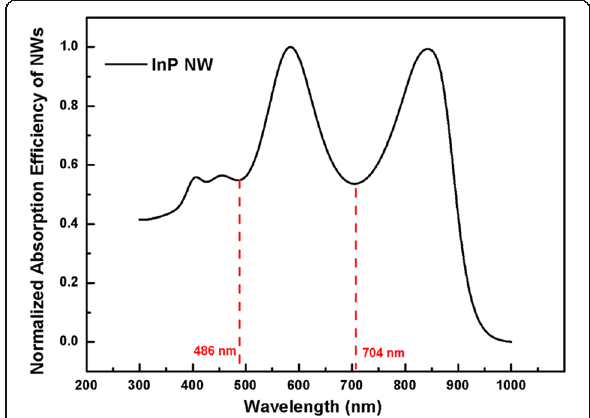
Fig. 7 Superposition of the absorption efficiencies of the major and the supplementary diameters of InP NWs